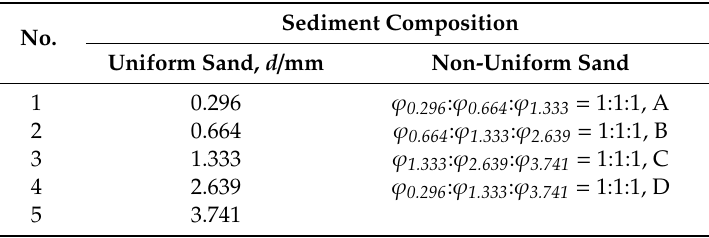
Table 1. The sediment